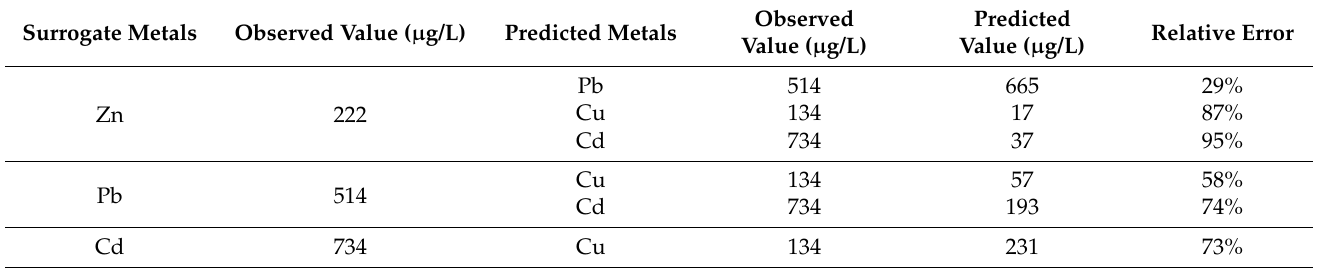
Table 4. External verification of the prediction models using observed data in the present